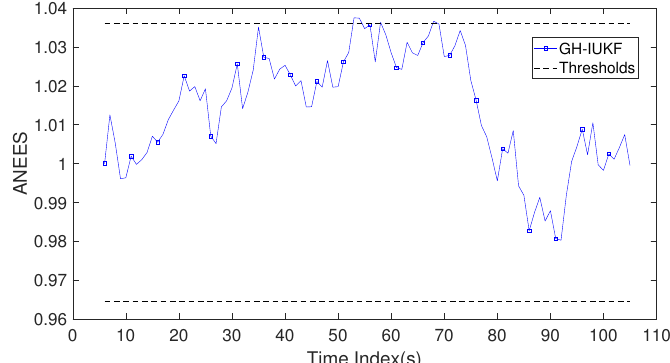
Figure 6. Average normalized estimation error squared (ANEES) of the Gauss–Helmert Iterated Unscented Kalman Filter (GH-IUKF) versus time index k.